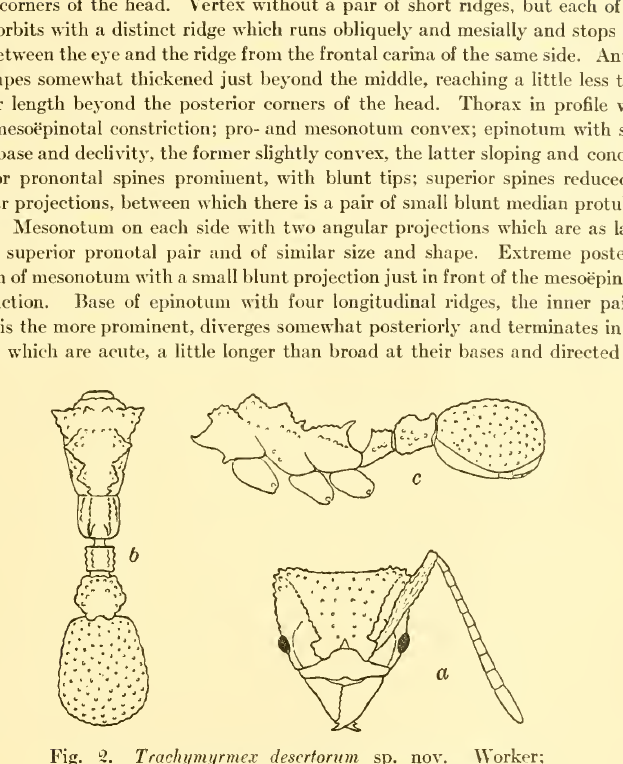
Fig. 2. Trachymyrmex desertorum sp. nov. Worker; a, head; h, thorax and abdomen seen from above; c, same seen in profile. ward, backward and slightly outward. Petiole with a very short, narrow peduncle; its node seen from above as long as broad, rectangular, with four longitudinal ridges; in profile the node is pointed above, with subequal anterior and posterior slopes, the former concave, the latter straight. Postpetiole twice as broad as the petiole, nearly as long as broad, broadest just behind the middle; its posterior border excised